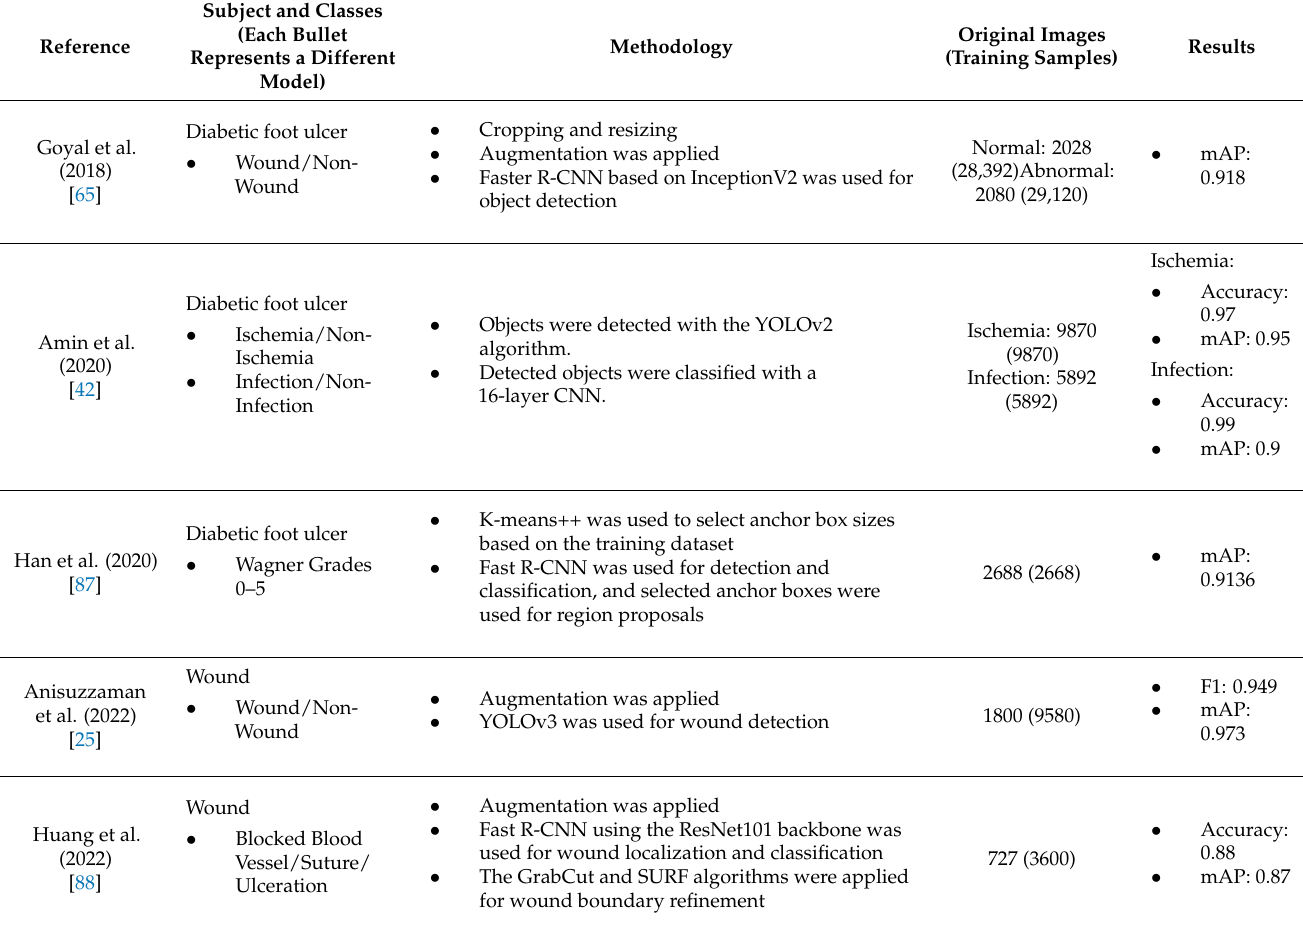
Table 5. Summary of papers on chronic wound